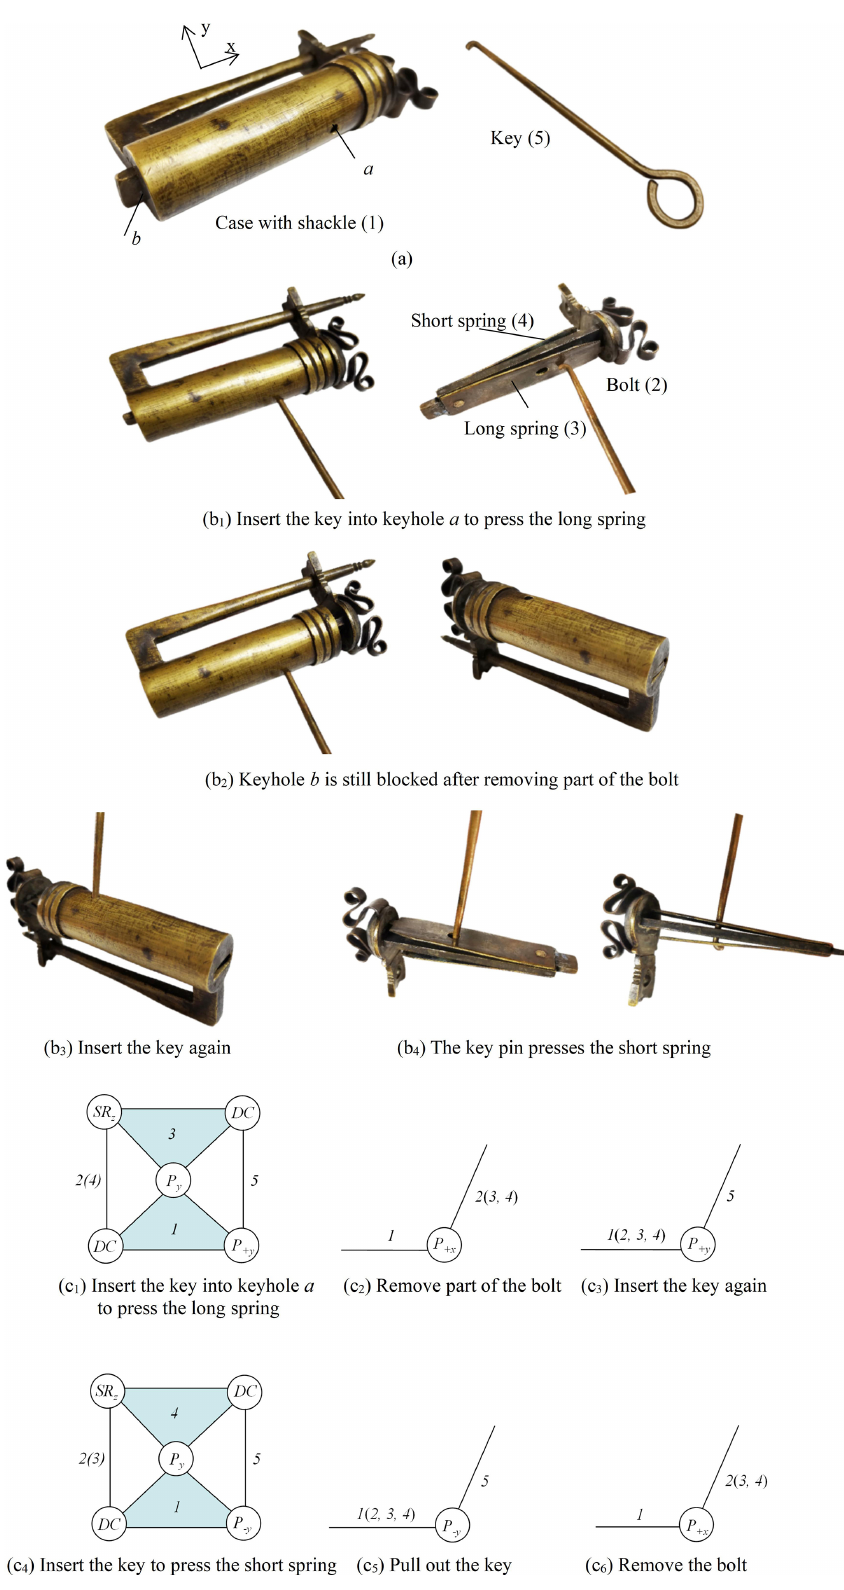
Figure 6. Copper padlock with poking hole – with one key (collection of Wang Xiquan ( ) from Shenyang,